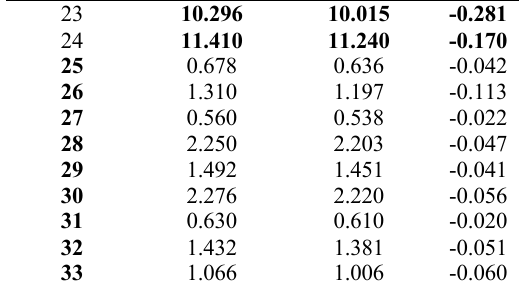
There are six outliers (bold and highlighted) in the POI results while 82 percent of the data are acceptable for RMSE calculation. The RMSE for the POI technique was 0.059m based on 27 acceptable data. The range of error for the waypoint technique were between -0.159m to 0.084m. The standard deviation for the waypoint technique was +0.053m. There were nine outliers (bold and highlighted) in the waypoint results while about 73 percent of the data was acceptable for RMSE calculation. The RMSE for the waypoint technique was 0.043m based on 24 acceptable data. Table 3. Errors for waypoint technique Sample